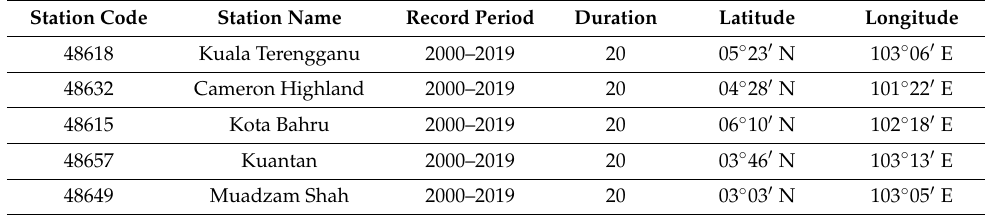
Figure 1. The geographical location of the meteorological stations. Table 1. The details of each meteorological station.